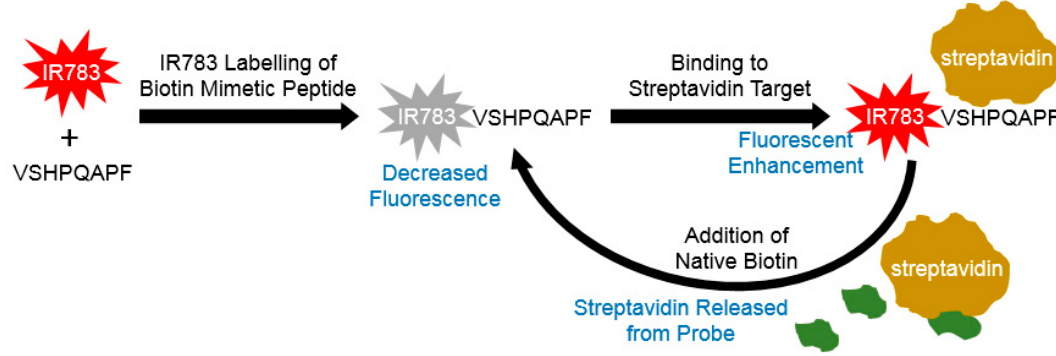
Figure 1. Schematic of IR-783 labeled peptide sequence VSHPQAPF serving as biotin mimic for recognition by streptavidin. Binding results in induction of turn-on fluorescence enhancement that is reversible upon addition of native biotin to displace the probe returning it to weak fluorescence.